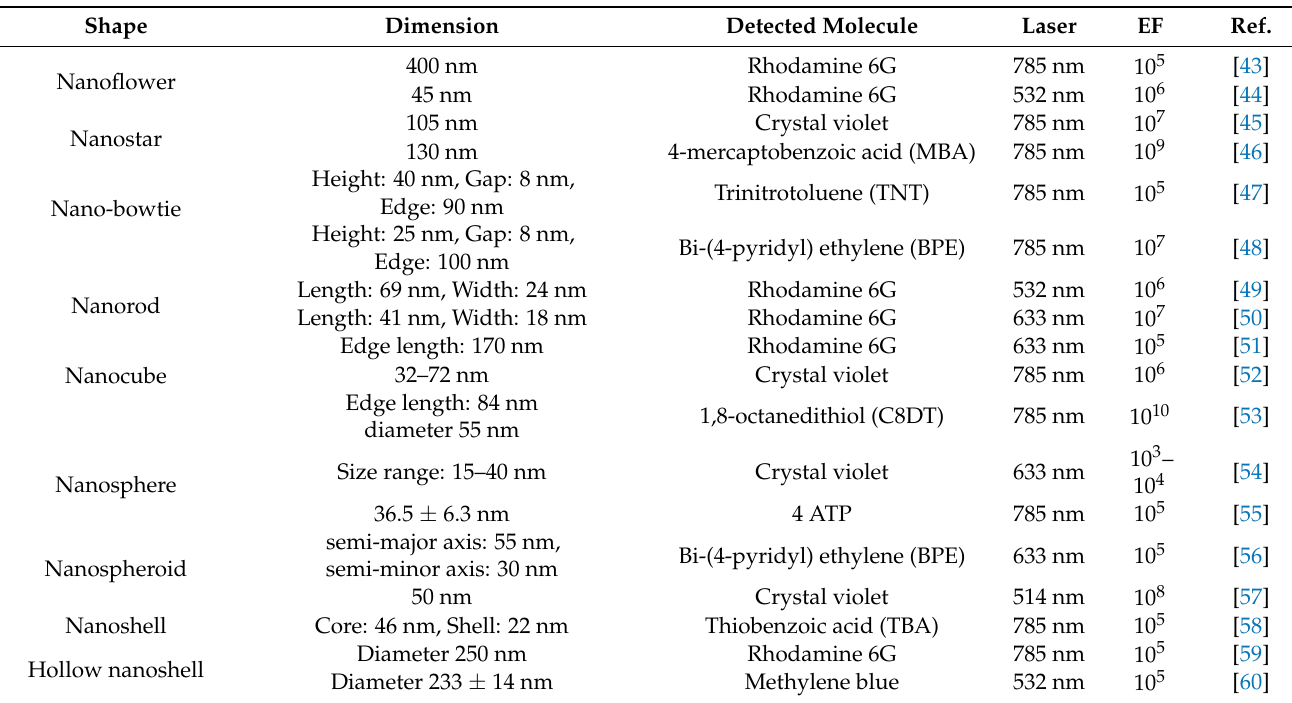
Table 1. Different shapes colloidal SERS active AuNPs. Dimension Detected